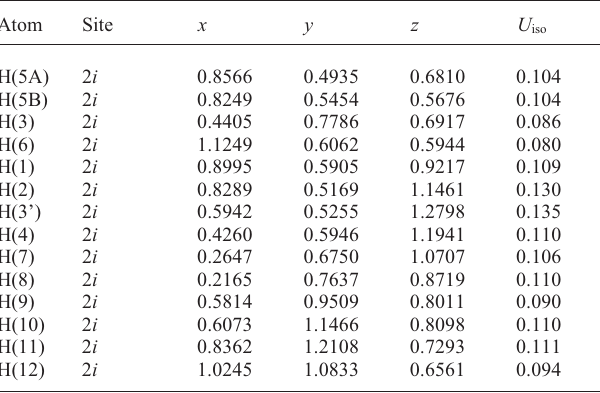
Table 2. Atomic coordinates and displacement parameters (in Å 2 )